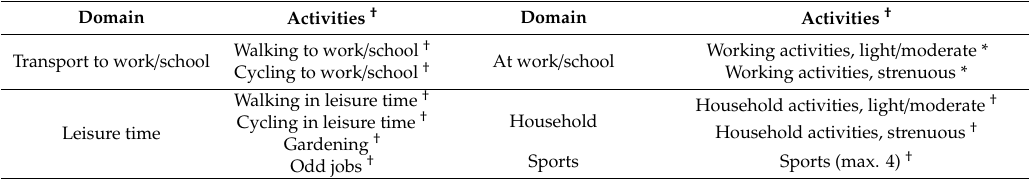
Table 2. Domains and activities of the Short Questionnaire to Assess Health-enhancing physical activity (SQUASH)